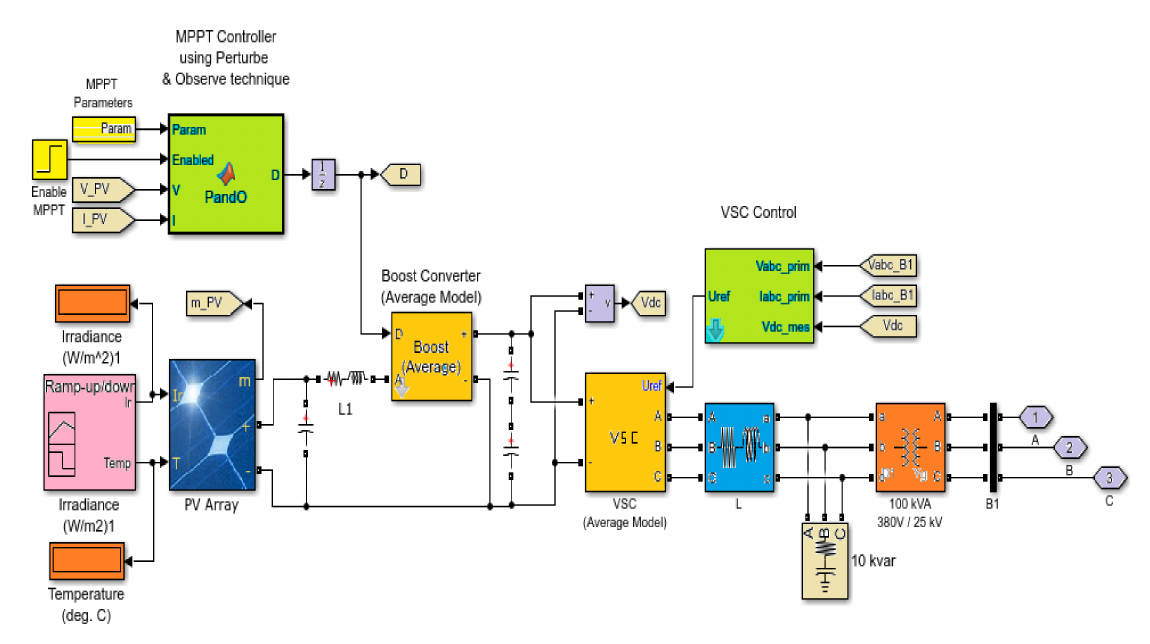
Figure 11. Block diagram of the solar photovoltaic system applied in this study. Based on the above proposed wind, solar and hydropower subsystems, a hybrid power system is finally obtained by MATLAB/Simulink [43], as shown in Figure 12.